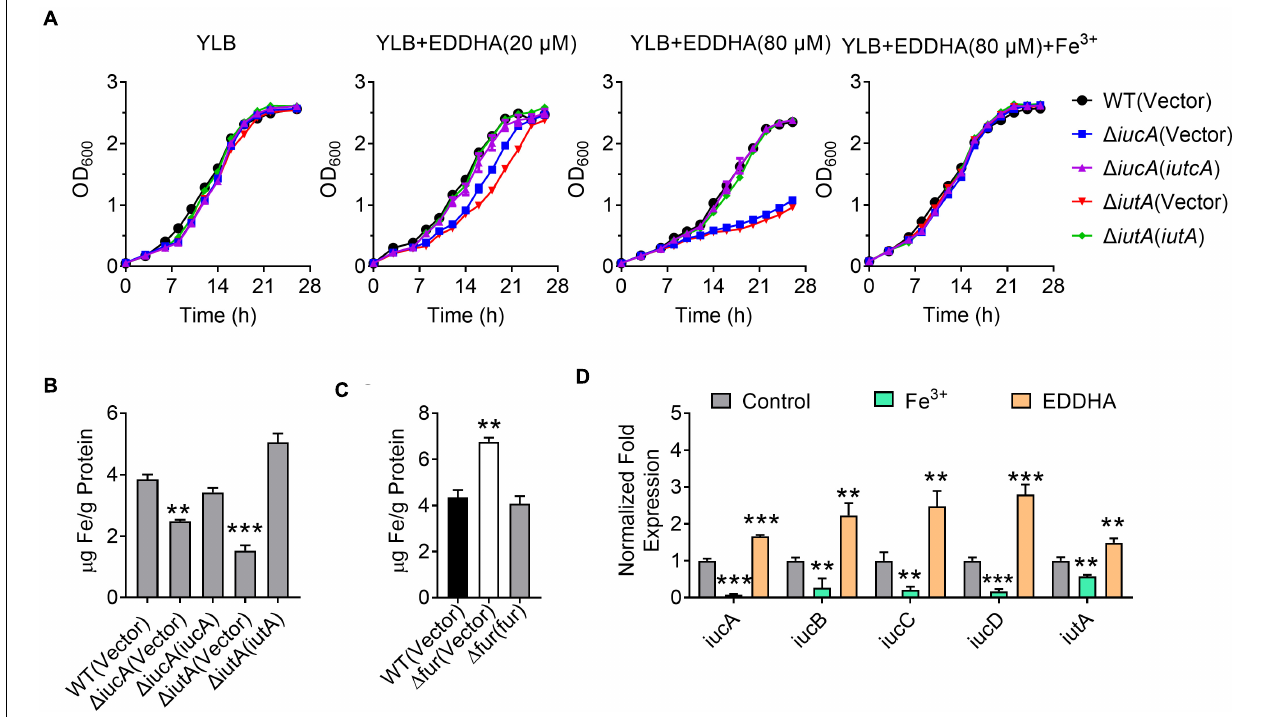
FIGURE 2 | Aerobactin produced by the iucABCD - iutA operon is crucial for iron acquisition in Y. pseudotuberculosis . (A) Saturated bacterial cultures were diluted to an OD 600 of 0.1 in Yersinia–Luria–Bertani (YLB) medium, YLB medium with 20 µ M EDDHA, YLB medium with 80 µ M EDDHA, or YLB medium with 80 µ M EDDHA and 200 µ M Fe 3 + . The growth of the cultures was monitored by measuring OD 600 at indicated time points. (B) Iron uptake requires aerobactin. Relevant Y. pseudotuberculosis strains were grown overnight in M9G minimal medium to the end of logarithmic phase, the intracellular iron associated with bacterial cells was measured by inductively coupled plasmon resonance atomic absorption spectrometry (ICP-MS). (C) The (cid:49) fur mutant accumulates intracellular iron. Intracellular iron was measured by ICP-MS in the Y. pseudotuberculosis WT, (cid:49) fur mutant, and complemented (cid:49) fur ( fur ) mutant strains grown to the end of logarithmic phase in YLB medium. (D) Expression of iucABCD - iutA responds to different iron concentration. Y. pseudotuberculosis WT grown in YLB medium with 50 µ M EDDHA and 200 µ M Fe 3 + , and qRT-PCR analysis of the expression of iucA , iucB , iucC , iucD, and iutA . Statistical analyses for the rest of the assays were performed using unpaired two-tailed Student’s t -test. Data represent the mean ± SEM of three biological replicates, each of which was performed with three technical replicates. ** p < 0.01; *** p <